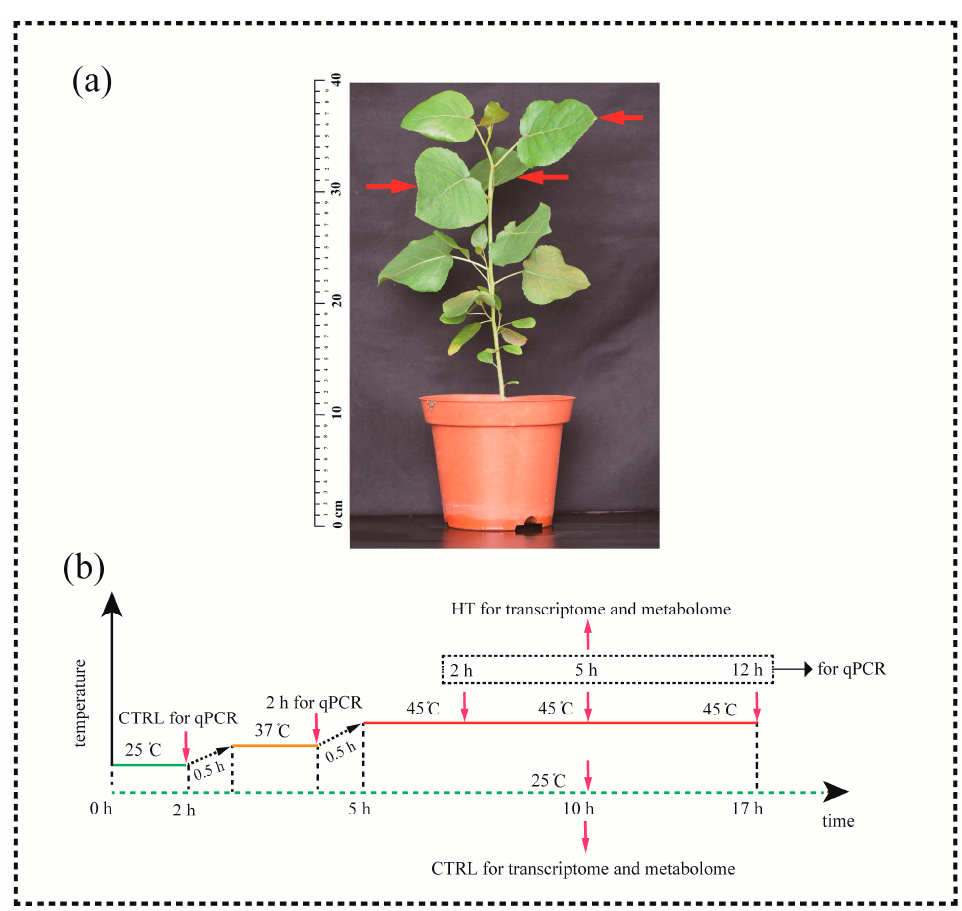
Figure 1. Plant material and experimental design. ( a ) Sampling locations (arrows). ( b ) Schematic diagram of the experimental design. HT, heat treatment; CTRL, control. The red line indicates the timeline of heat treatment. The green dashed line indicates the timeline of control. The red arrows indicate sampling time points (for qPCR: 25 °C 2 h, 37 °C 2h, 45 °C 2h , 5h, 12h; for transcriptome and metabolome: 45 °C 5h, 25 °C 10h).